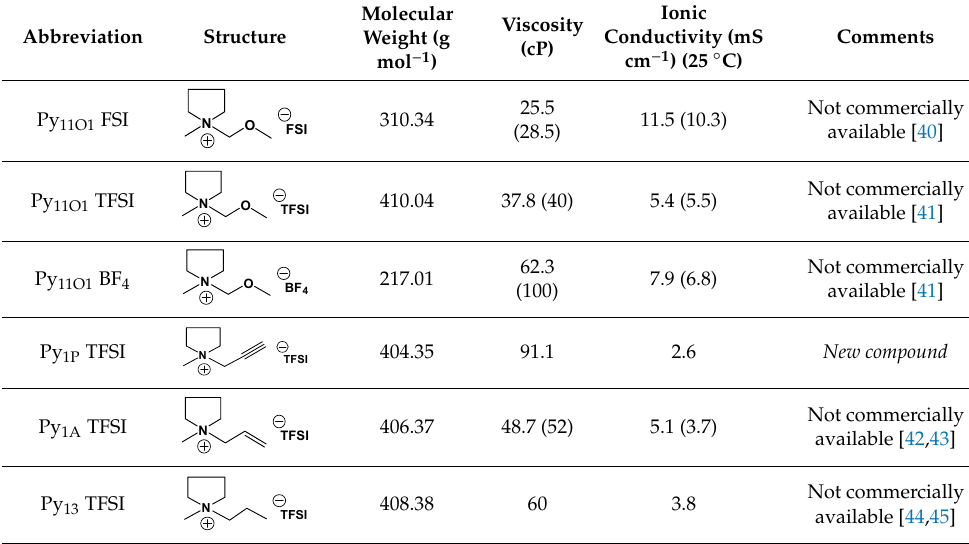
Table 1. Properties of Pyrrolidinium-based ionic liquids (ILs).